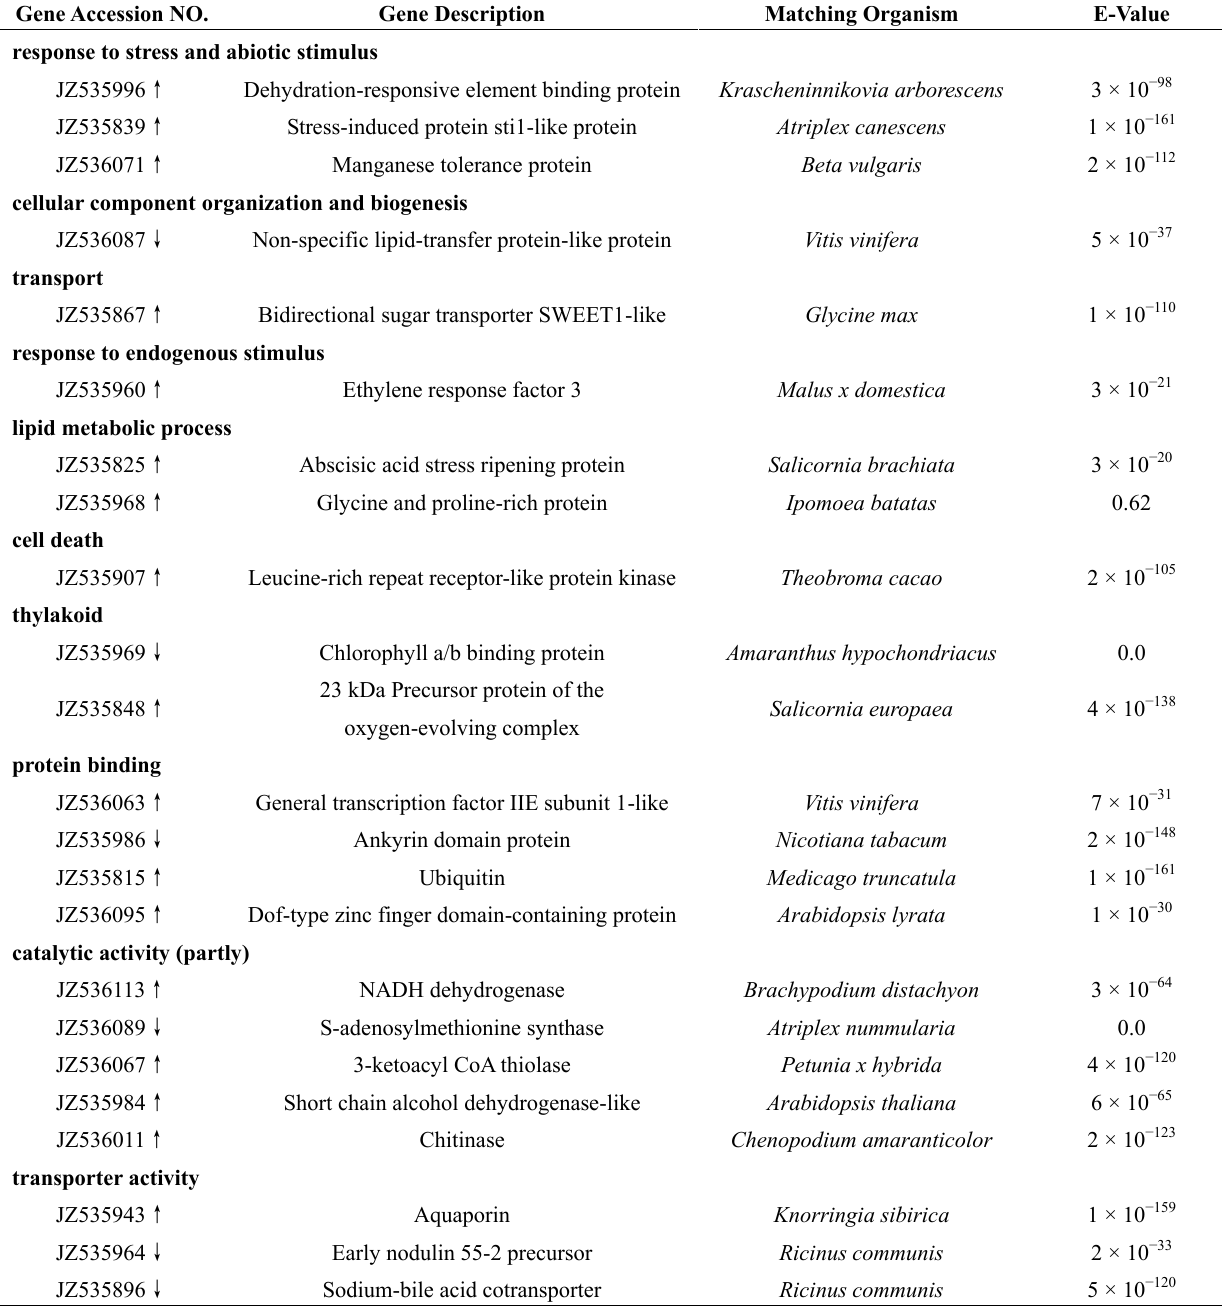
Table 1. Genes potentially involved in salt tolerance in A.